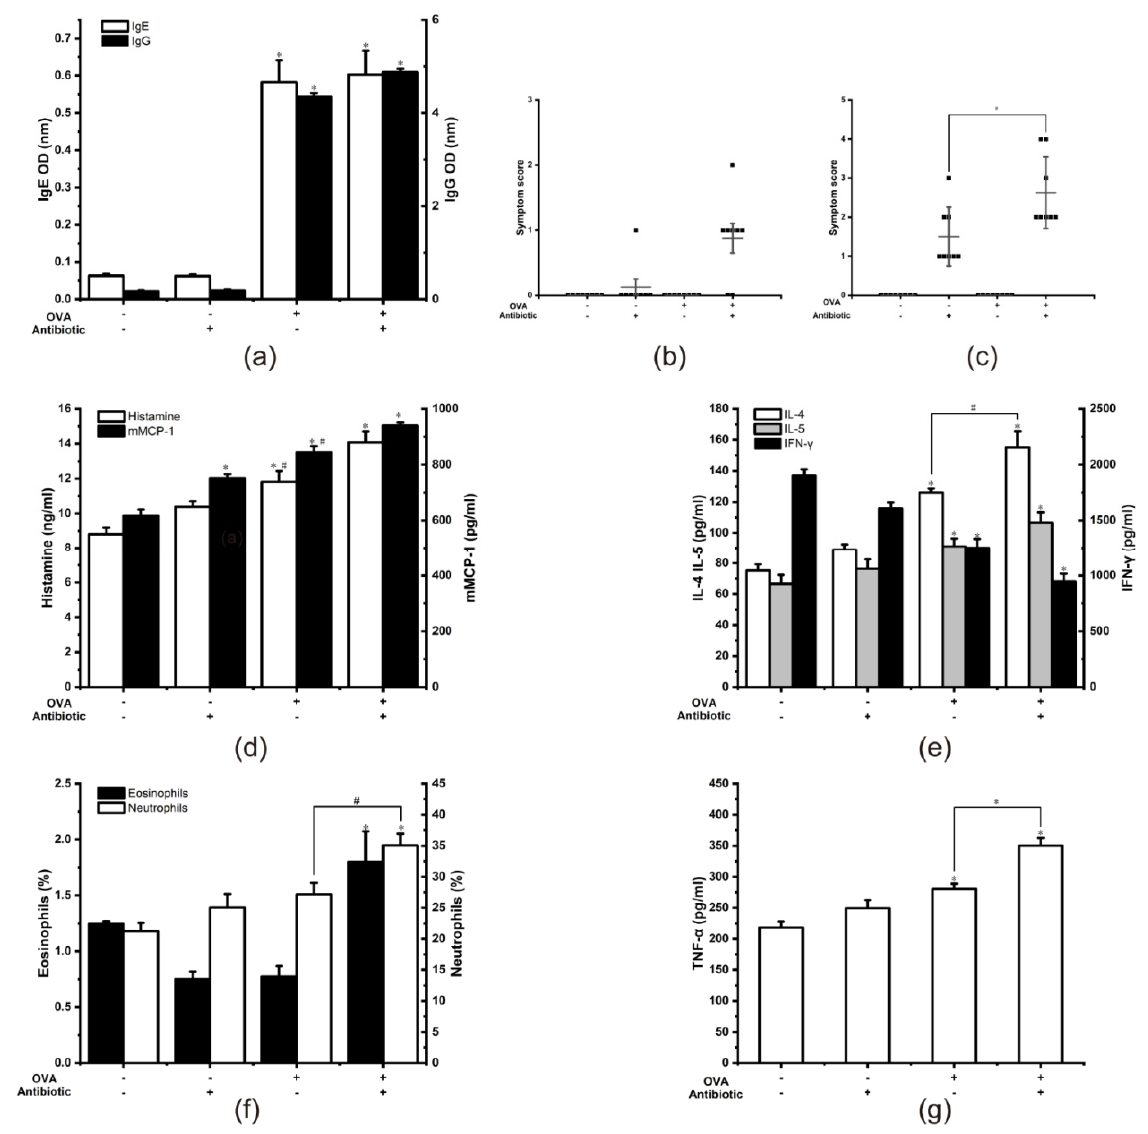
Figure 6. Gut microbiota dysbiosis causes more severe symptoms when mice that are already in a sensitized state are re-exposed to allergens ( a ). Specific IgE and IgG1 ( b ). Allergy symptom score of the first challenge ( c ). Allergy symptom score of the second challenge ( d ). Histamine and mMCP-1 ( e ). Th1/Th2 cytokine ( f ). Blood cells, including the percentage of eosinophils and neutrophils ( g ). TNF- α . * p < 0.05 as compared to the OVA-Antibiotic- group. # p < 0.05 as compared to the OVA+Antibiotic- group.